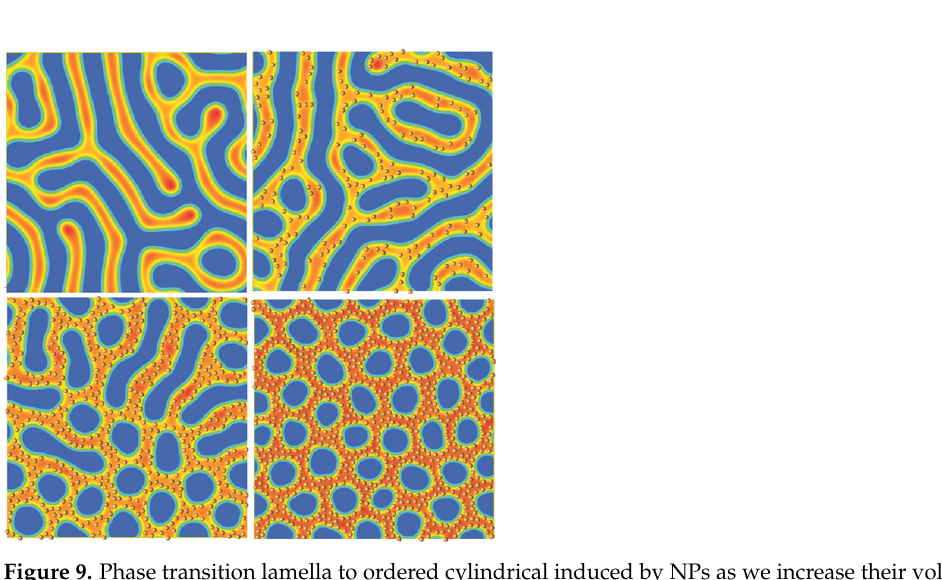
Figure 9. Phase transition lamella to ordered cylindrical induced by NPs as we increase their volume fraction with values φ p = 0, 0.15, 0.35 and 0.55, respectively. Reprinted with permissions from Ref. [144], Copyright 2017 Wiley .